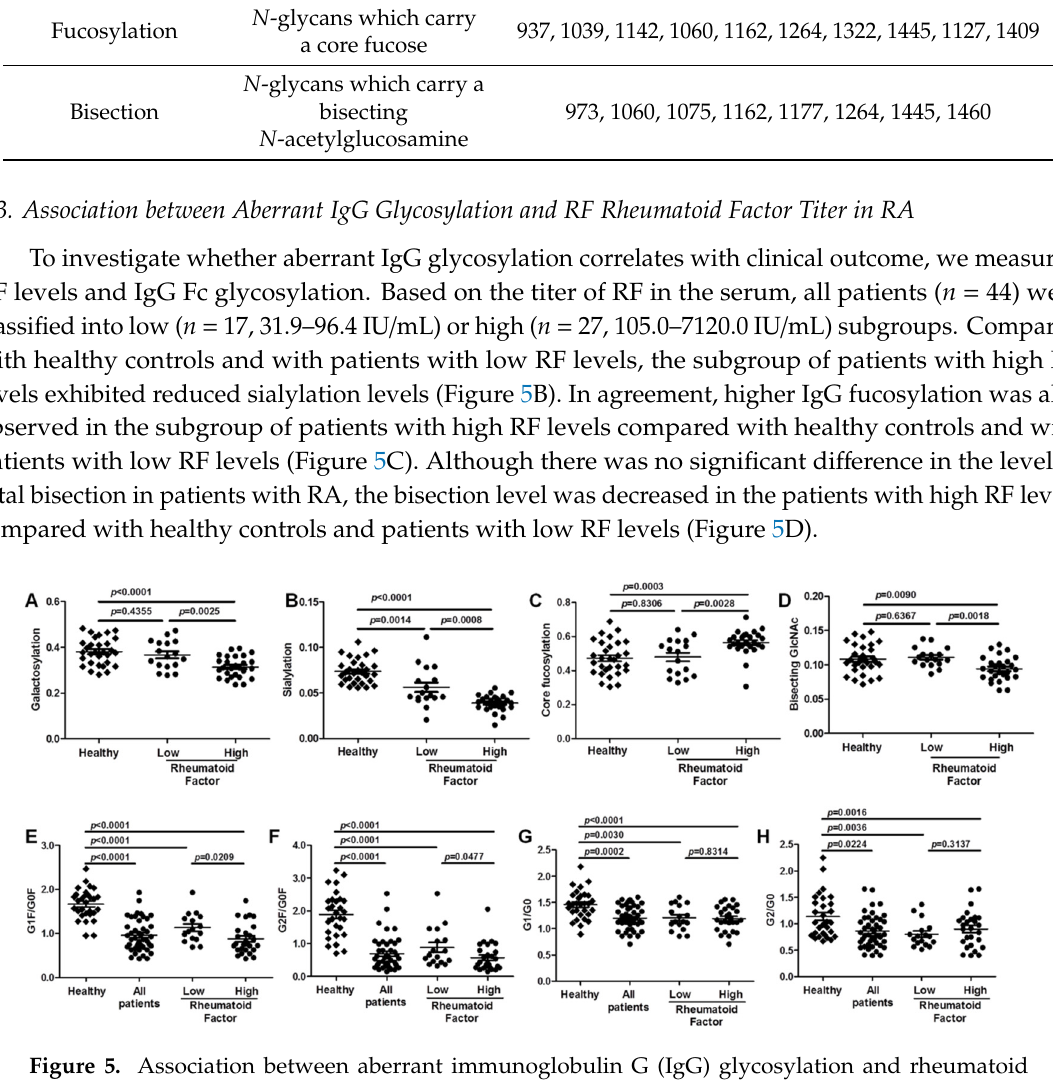
Figure 5. Association between aberrant immunoglobulin G (IgG) glycosylation and rheumatoid factor (RF) titer in rheumatoid arthritis. The IgG galactosylation ( A ), sialylation ( B ), core fucosylation ( C ), bisection ( D ), G1F/G0F ( E ), G2F/G0F ( F ), G1F0/G0F0 ( G ), and G2F0/G0F0 ( H ) for all patients, as well as patients with different RF levels, are aberrant compared with healthy controls. Statistical significance was evaluated using two-tailed Student’s t-test. Error bar indicates standard deviation (ns, no significance; p < 0.05 indicated statistical significance).